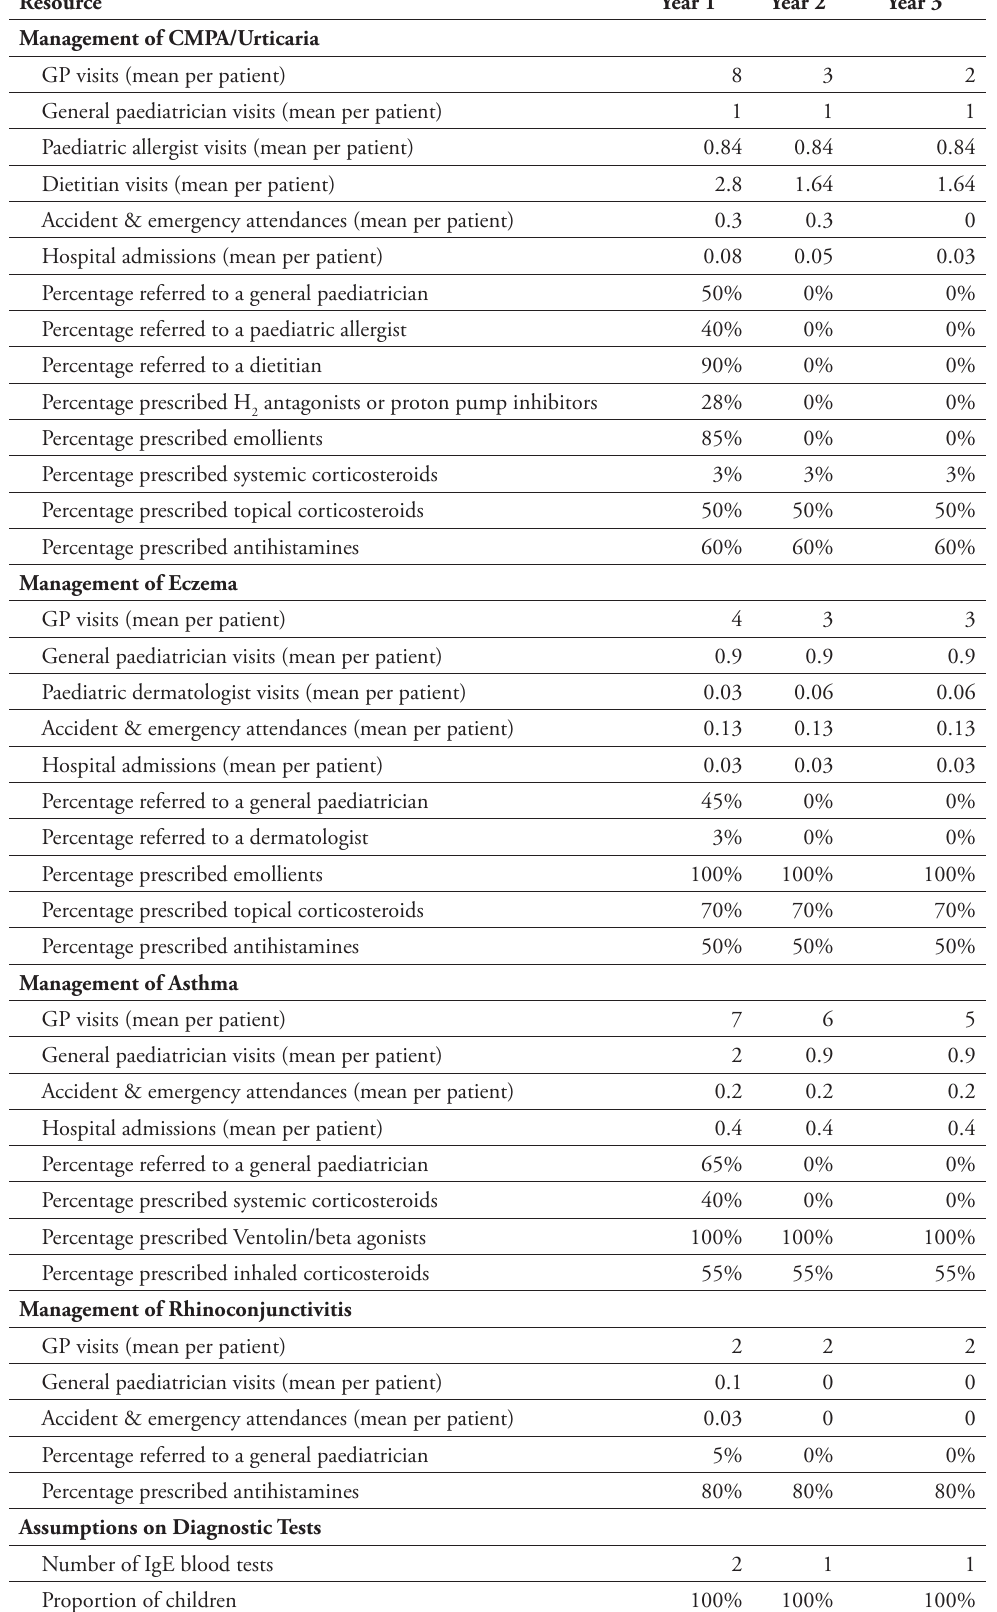
Table 2. Units of Resources Required To Manage CMPA and its Allergic